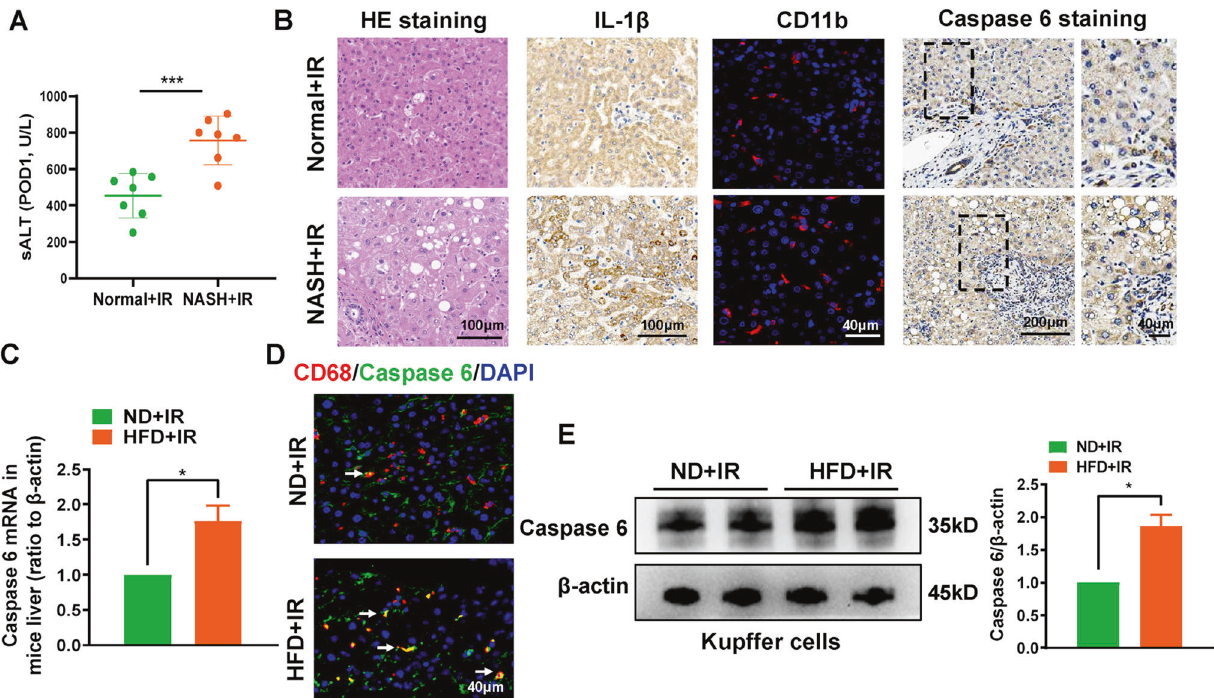
Fig. 1 Caspase 6 expression is positively associated with hepatic IR injury in fatty livers. Liver samples were harvested from patients during hepatectomy (after hepatic portal vein occlusion). A sALT was detected at the fi rst day postoperatively after hepatectomy, N = 7/group; ( B ) H&E staining, IL-1 β IHC staining, CD11b IF staining, Caspase 6 IHC staining in human liver biopsies, scale bar: 200 µm, 100 µm, 50 µm; ( C ) qRT- PCR analysis of Caspase 6 in IR-stressed livers with HFD or ND diets; ( D ) IF analysis of AlexaFluor488-labeled Caspase 6 and Cy5-labeled CD68 positive macrophages in ischemic livers, Scale bars, 40 µm; ( E ) WB-assisted Caspase 6 expression pro fi le in Kupffer cells isolated from mice ischemic livers. N = 4 – 7/group, all data represent the mean ± SD, * p < 0.05, ** p < 0.01, *** p <